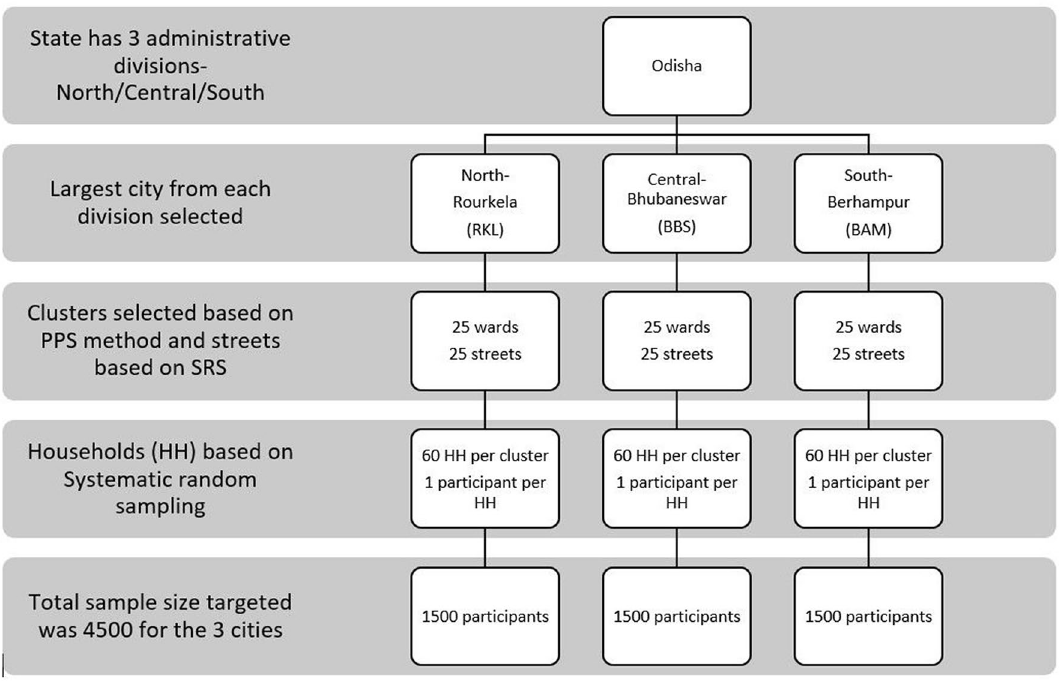
Figure 1. Sampling framework of the Multi-stage sampling